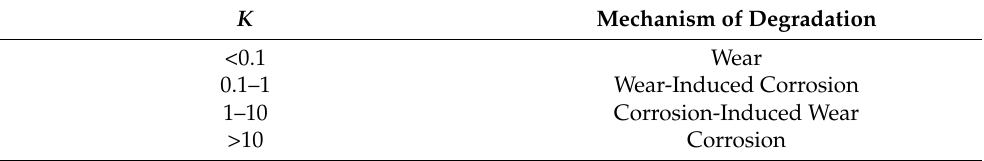
Table 1. Regime of wear according to K